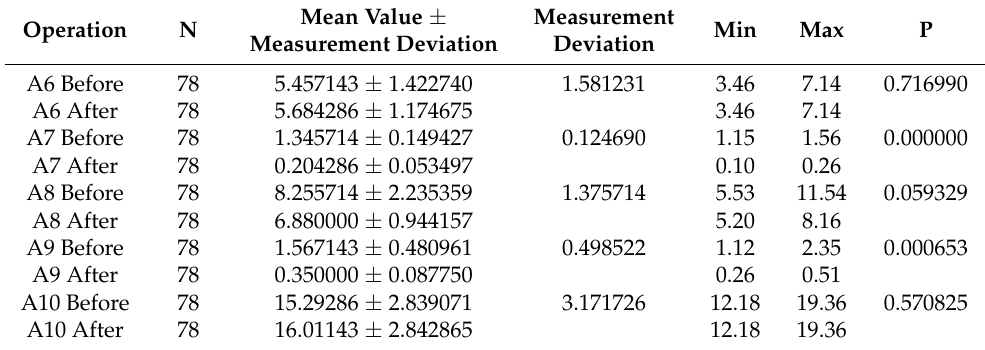
Table 6. Statistical evaluation of measured data A6–A10.